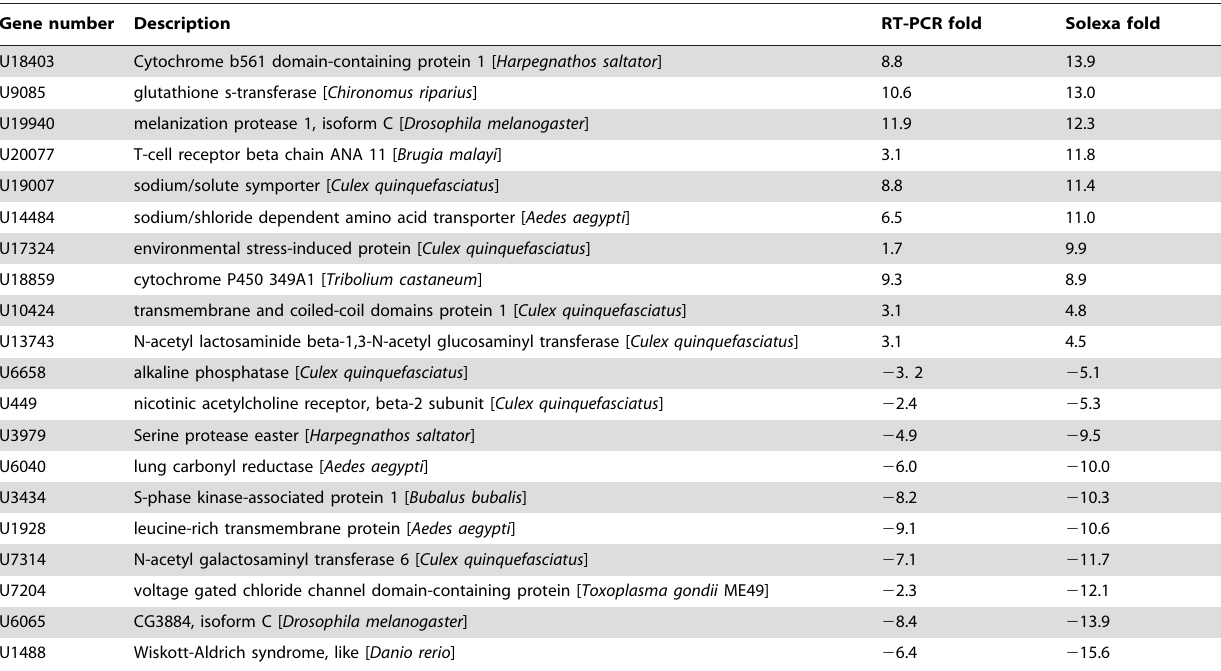
Table 4. Genes selected for Real-time